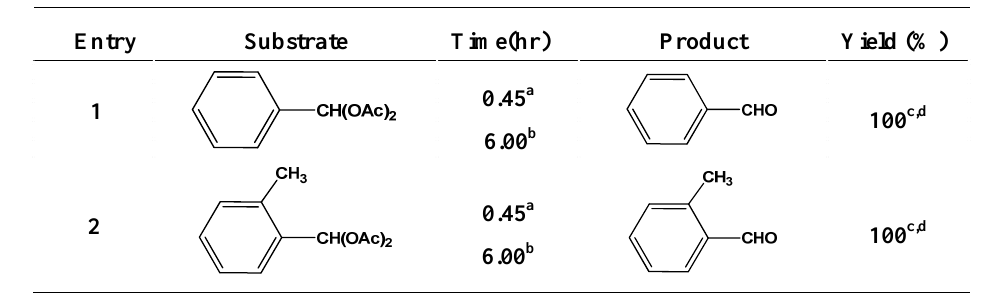
Table 3. 1,1-Diacetates deprotection reaction to